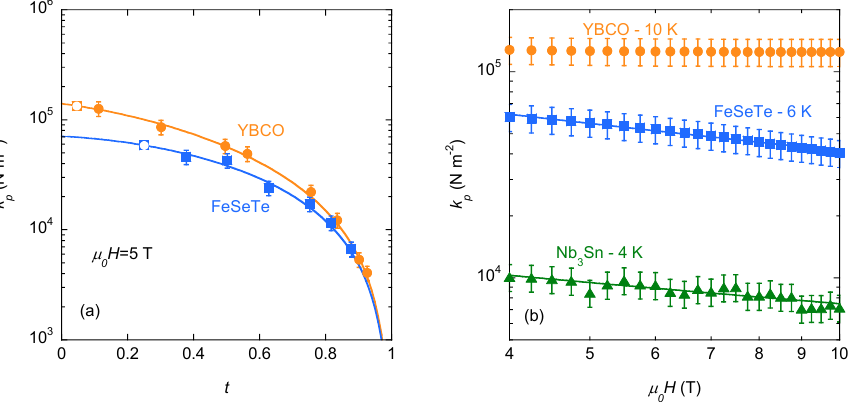
Figure 2. ( a ) Pinning constant k p , measured on YBCO (orange circles) and FeSeTe (blue squares) in zero field cooling conditions (ZFC) at 5 T as a function of the reduced tem- perature t = T / T c .